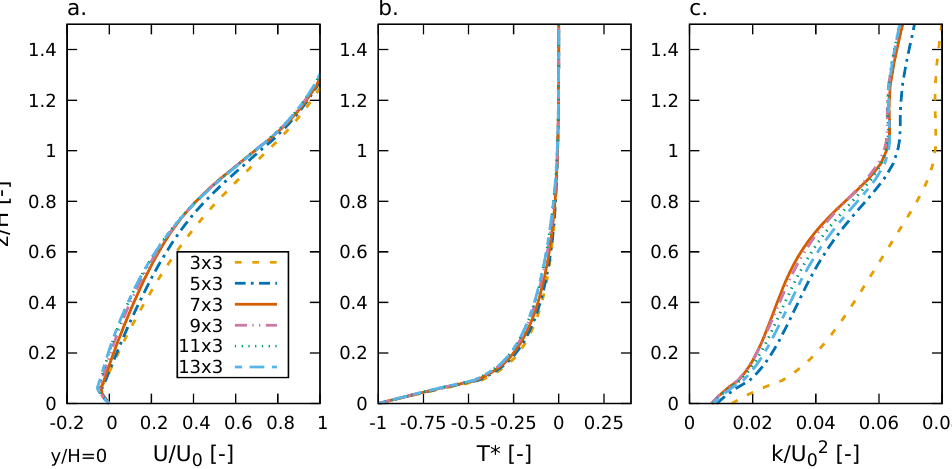
Figure 2. Normalised profiles along a vertical sampling line in the middle of the open square ( y / H = 0) and up to a height of z / H = 1.5 above the water body: ( a ) streamwise velocity ( U / U 0 ); ( b ) temperature ( T ∗ ); ( c ) turbulent kinetic energy ( k / U 02 ).